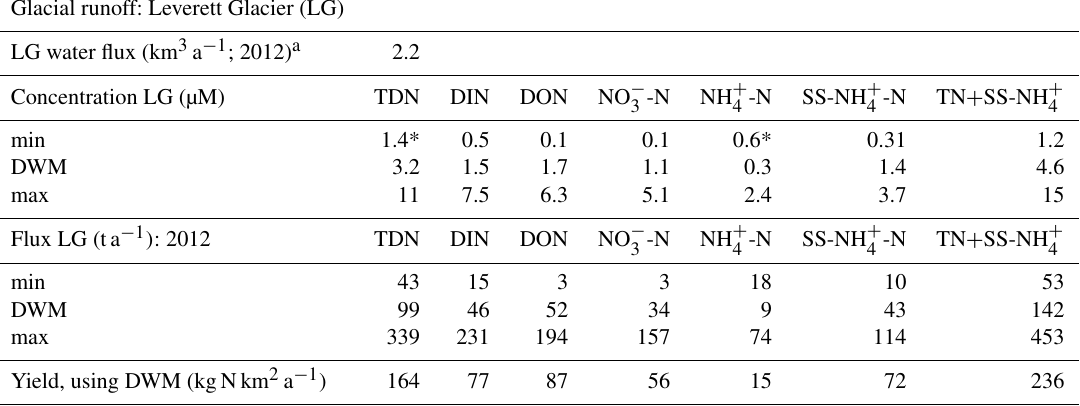
Table 2. Estimates of seasonal fluxes of total dissolved (TDN) and particulate nitrogen (SS-NH + Glacier in 2012. Values marked with an asterisk were below the detection limit. Hence, the minimum concentration is set to the detection limit of the